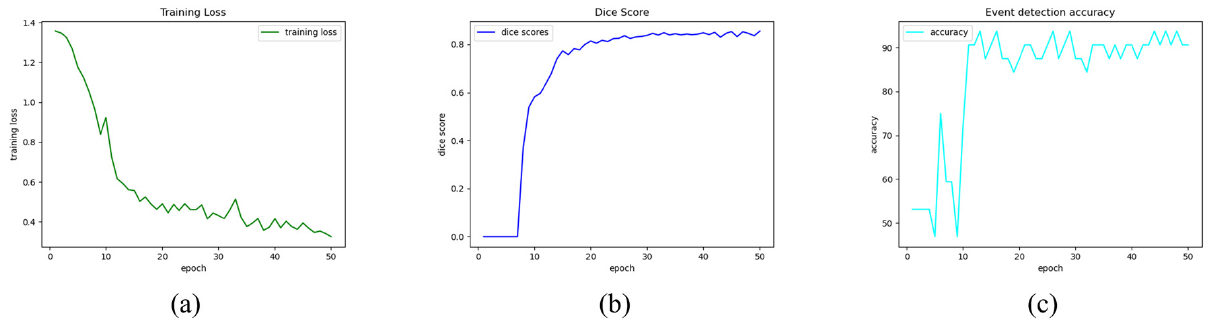
Figure 4. Training and validation metrics trends. Multi-task Training Loss ( a ), Validation Dice Score for semantic segmentation branch ( b ), and Validation accuracy for event detection branch ( c ). Table 1. Comparison between prediction rate and frame rate during video